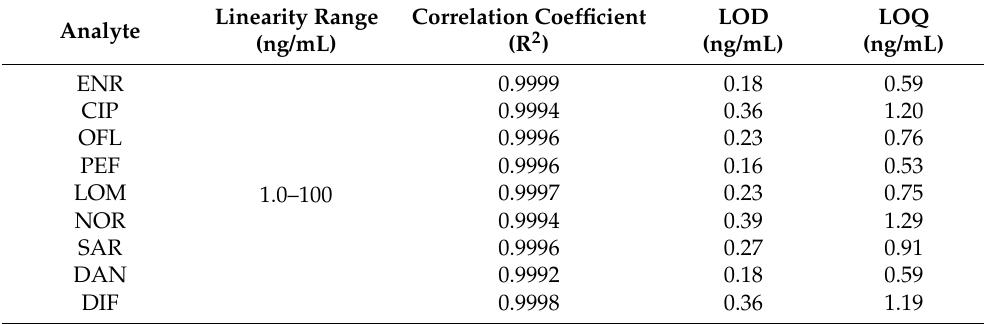
Table 2. Performance of the